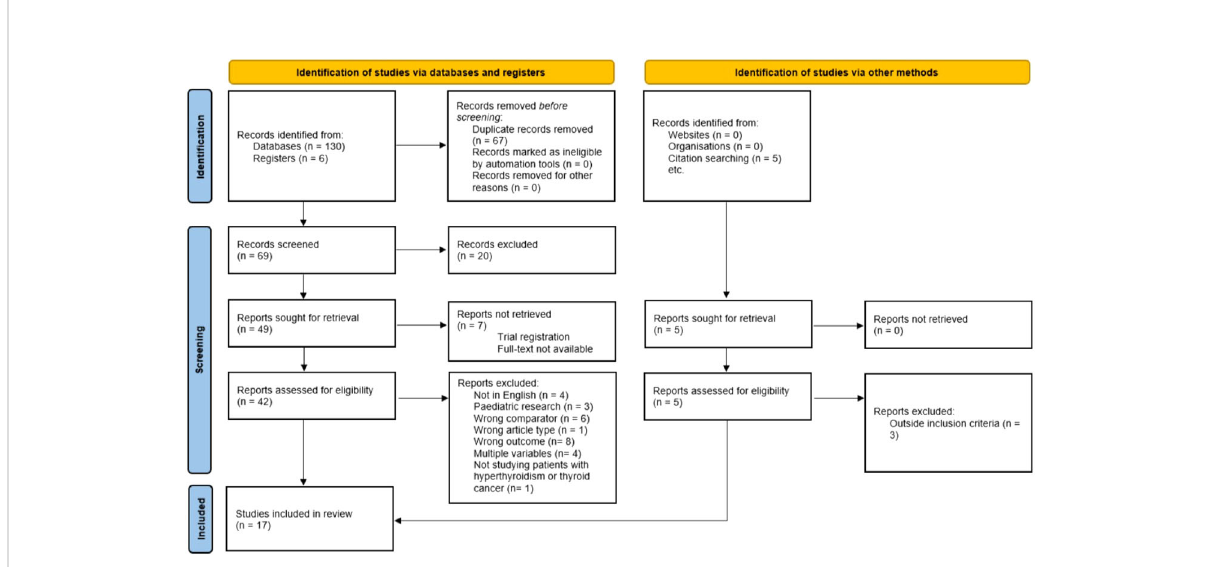
FIGURE 1 PRISMA 2020 fl ow diagram for systematic review. From: Page MJ, McKenzie JE, Bossuyt PM, Boutron I, Hoffmann TC, Mulrow CD, et al. The PRISMA 2020 statement: an updated guideline for reporting systematic reviews. BMJ 2021;372:n71. doi: 10.1136/bmj.n71. For more information, visit: